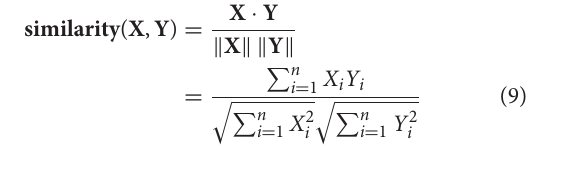
where W 1 and W 2 denote the first and second linear projection matrix, respectively. b 1 and b 2 denote the first and second bias,